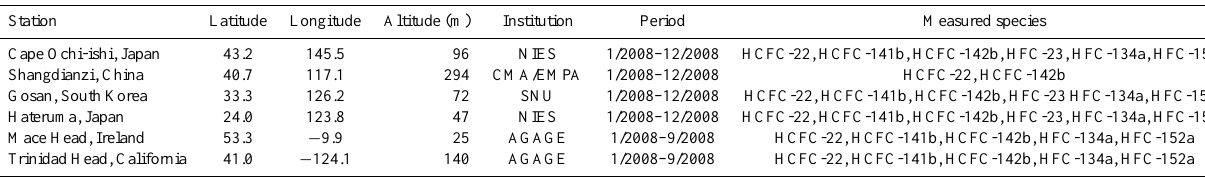
Table 1. List of the measurement stations, their coordinates, the operating institutions, the period and the species for which data were available. Station Latitude Longitude Altitude (m) Institution Period Measured species Cape Ochi-ishi,